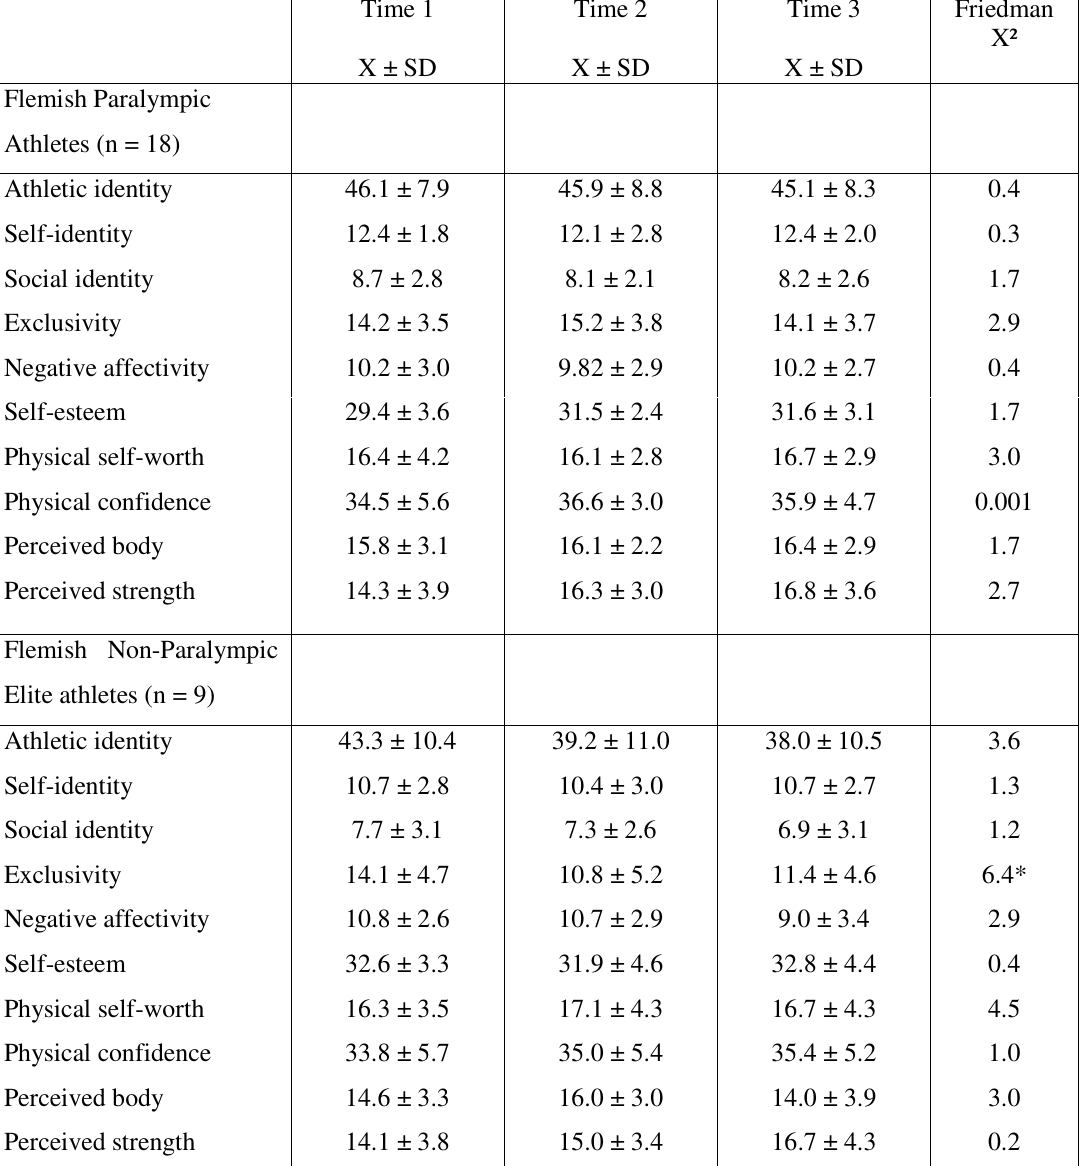
Stability of athletic identity and (physical) self-esteem over time in Flemish Paralympic and Non- Paralympic Elite athletes with a disability [time 1 = 11 months prior to 2004 Athens Paralympic Games (APG); time 2 = 2 months prior to 2004 APG; time 3 = 1 month after the 2004